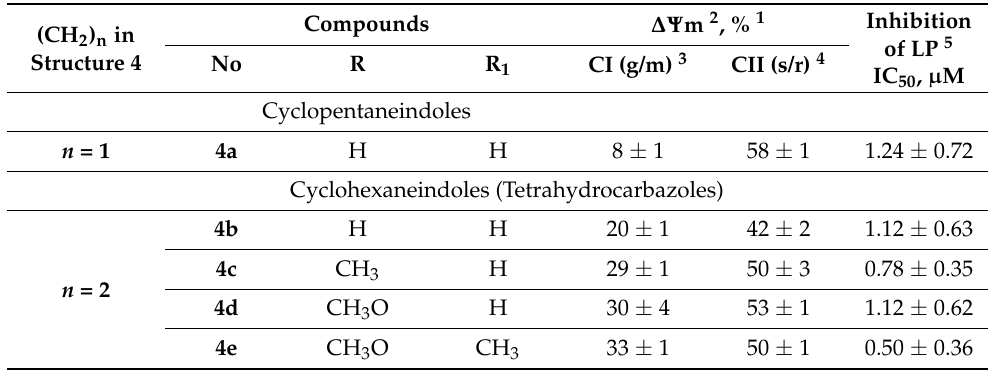
Table 4. Effect of MB –cycloalcaneindole conjugates on the characteristics of isolated rat liver mito- chondria and the inhibition of LP in rat brain homogenates (RBH) induced by 0.5 mM Fe 3+ (IC 50 , µM).